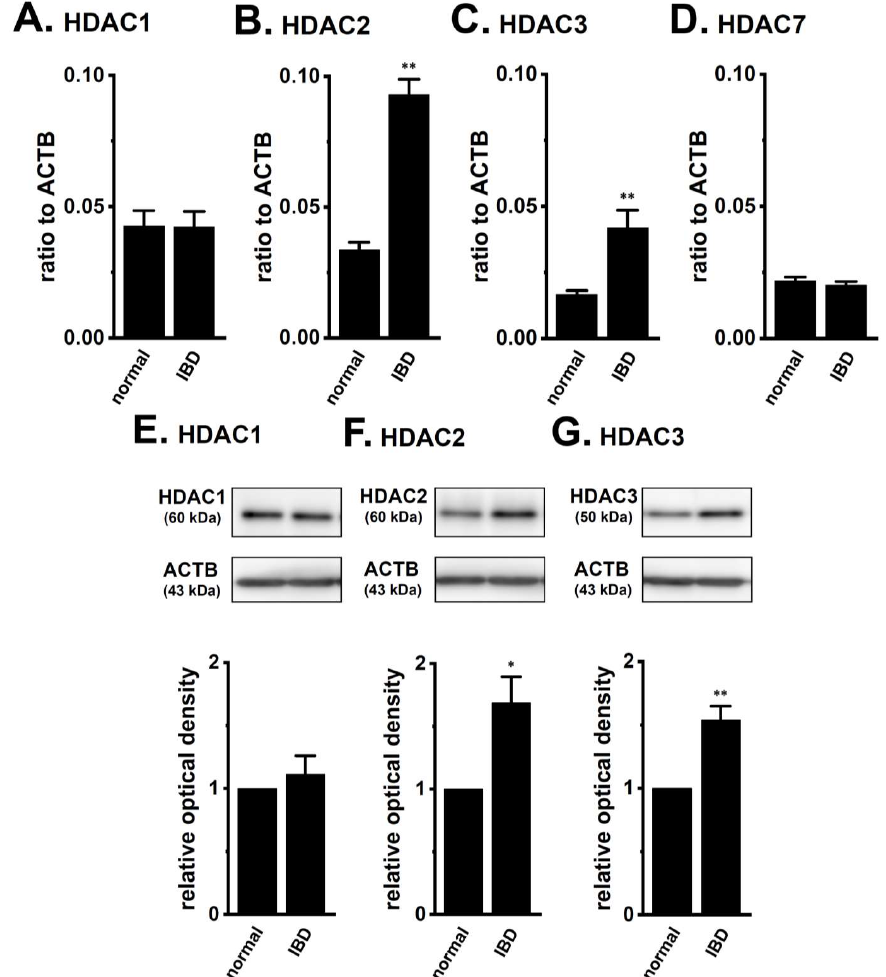
Figure 3. Expression levels of HDAC1, 2, 3, and 7 in splenic CD4 + T cells of IBD model mice. ( A – D ) Real-time PCR assay for HDAC1 ( A ), HDAC2 ( B ), HDAC3 ( C ), and HDAC7 ( D ) in the splenic CD4 + T cells of “normal” and “IBD” model mice ( n = 4 for each). Expression levels were expressed as a ratio to ACTB. ( E – G ) Protein lysates of the splenic CD4 + T cells of “normal” and “IBD” model mice were probed by immunoblotting with anti-HDAC1 ( E ), HDAC2 ( F ), HDAC3 ( G ) (upper panel) and anti-ACTB (lower panel, E – G ) antibodies on the same filter. Summarized results were obtained as the optical density of HDACs and ACTB band signals. After compensation for the optical density of the HDAC protein band signal with that of the ACTB signal, the HDAC signal in the vehicle control was expressed as 1.0 ( n = 4 for each). The results are expressed as means ± SEM. *, **: p < 0.05, 0.01 vs. normal mice.